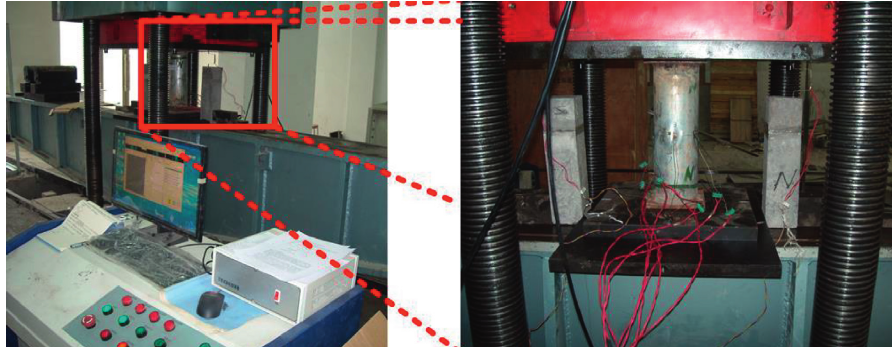
Figure 4: Schematic view and details for testing setup.